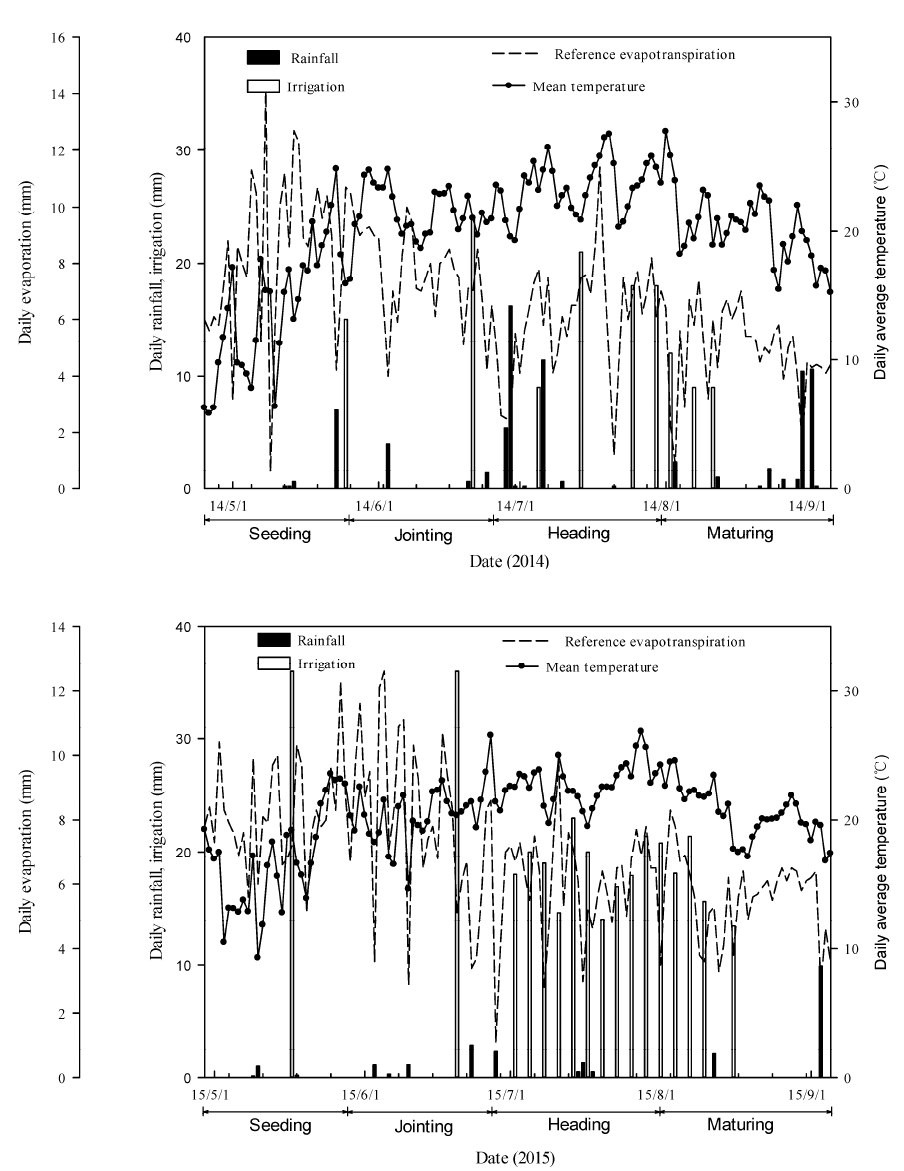
Figure 1. Rainfall, evaporation, irrigation, and temperature during crop growth stages in 2014 and